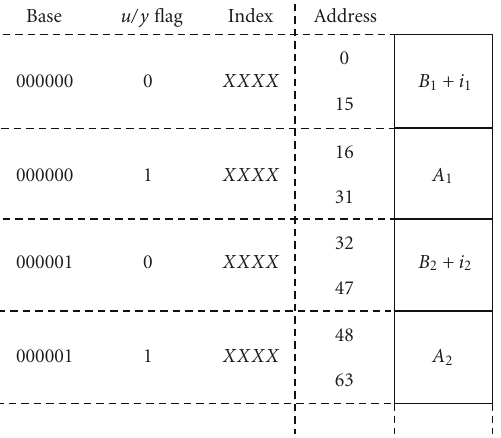
Figure 14: Address space of the nodal template memory.